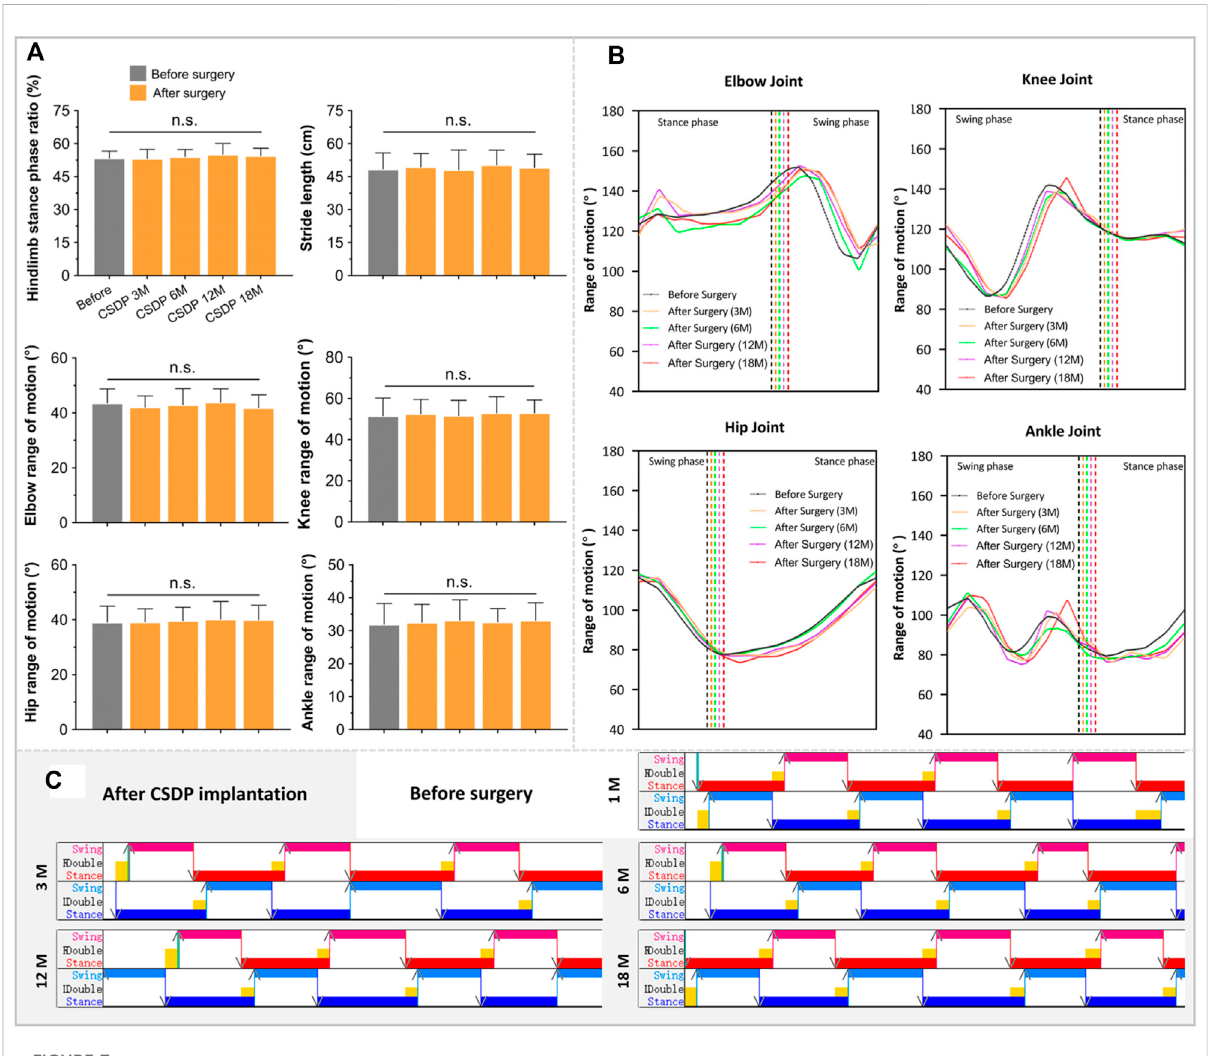
FIGURE 7 The foundation date of kinematic analysis in non-human primates. (A) Quantitative detections of stance phase ratio, stride length, and limb rangeofmotionofelbow, hip,knee,and ankle. (B) Thebasicstatisticsofchangesinjointtrajectory valuesat1 monthbefore surgeryand3,6, 12,and 18 months after surgery. (C) Visualized strip-based data of forelimb and hindlimb stance and swing phases. n.s., no statistical difference. ( n =